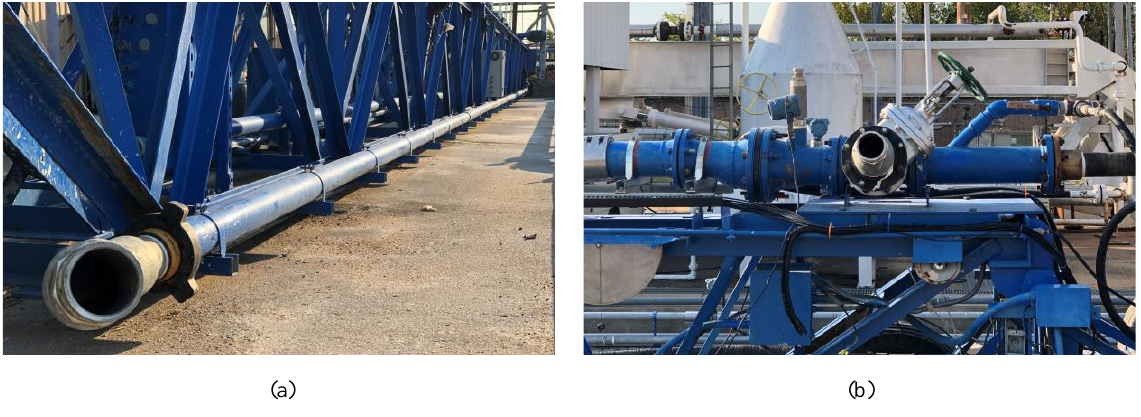
Figure 3. Pump connection ( a ) and mud return ( b ) . For higher-rheology fluids, a triplex pump supplied by an oil-field service company was used. Liquid flow rate was measured using a Micro-Motion TM Emerson (St. Louis, MO, USA) mass flow meter. Figure 4 shows the flow rig built for this study.